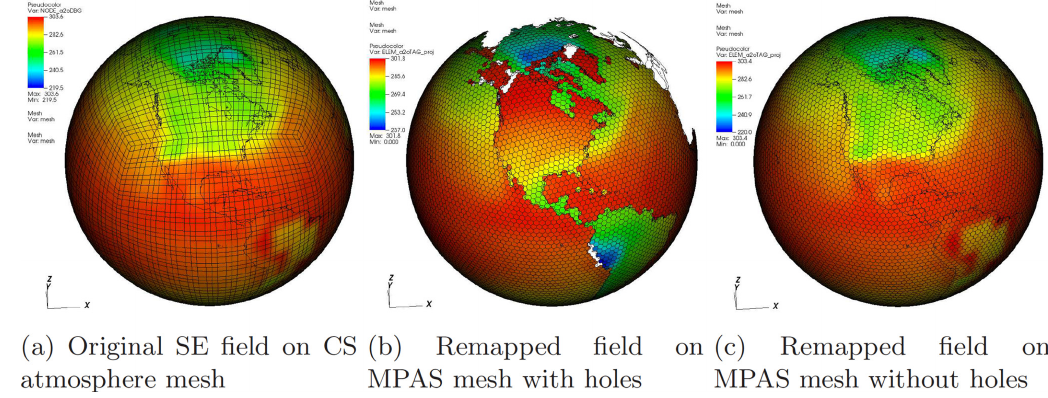
Figure 10. Projection of the NE11 SE bottom atmospheric temperature field onto the MPAS ocean grid. Table 1. Strong scaling on Cori for SE → FV projection with two different resolutions on a fully colocated PE layout.